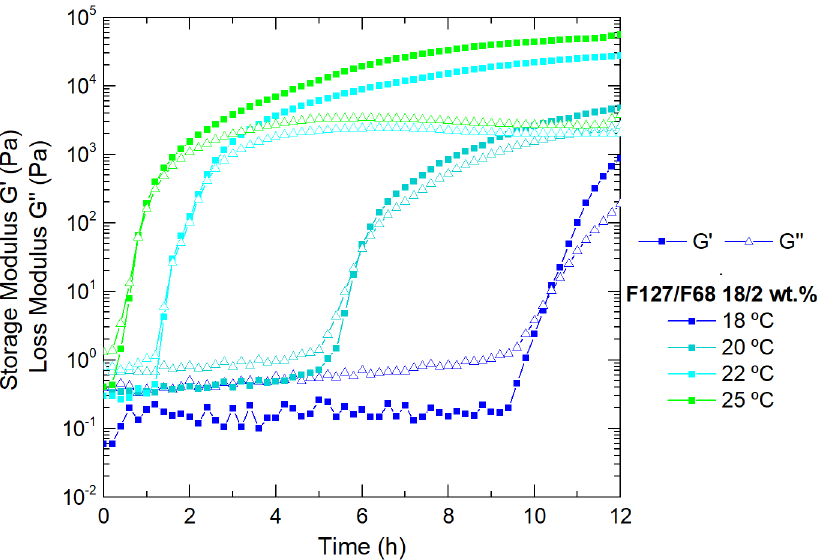
Figure 3. Viscoelastic behavior of the selected Pluronic formulation (F127/F68 18/2 wt.%) as a func- tion of time, at a fixed temperature (18 °C, 20 °C, 22 °C, and 25 °C).